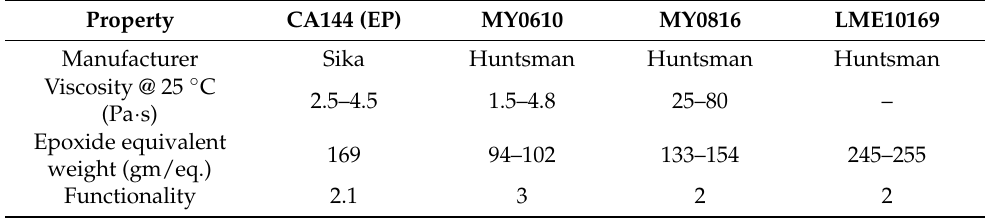
Figure 2. Molecular structure of ( a ) distilled triglycidylether of meta-amino phenol (Araldite MY0610), ( b ) 1,6-Naphthalene di epoxy (Araldite MY0816) and ( c ) fluorene di epoxy resin (LME10169). Table 3. Properties of different epoxy systems used [17,18,21].